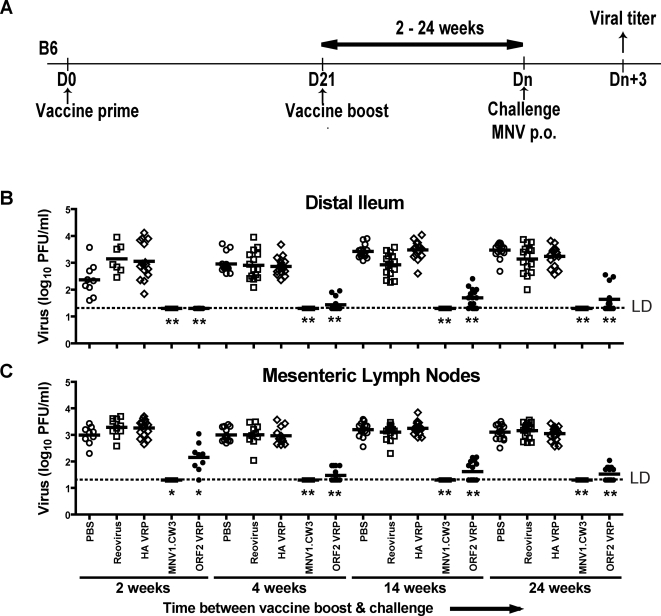
Long-term vaccination against MNV using a live MNV strain and ORF2 VRPs.(A) Vaccination protocol used in long-term vaccination. Viral titers in (B) distal ileum and (C) MLN of WT mice after MNV1.CW3 challenge following vaccination with indicated vaccines. These data are pooled from three independent experiments with 3–5 mice per group in each experiment. (**) indicates p<0.0001, (*) indicates p<0.05. Unless otherwise stated, live virus vaccinations are compared to vaccination with reovirus, and VRP vaccinations are compared to HA VRP. LD indicates the limit of detection.